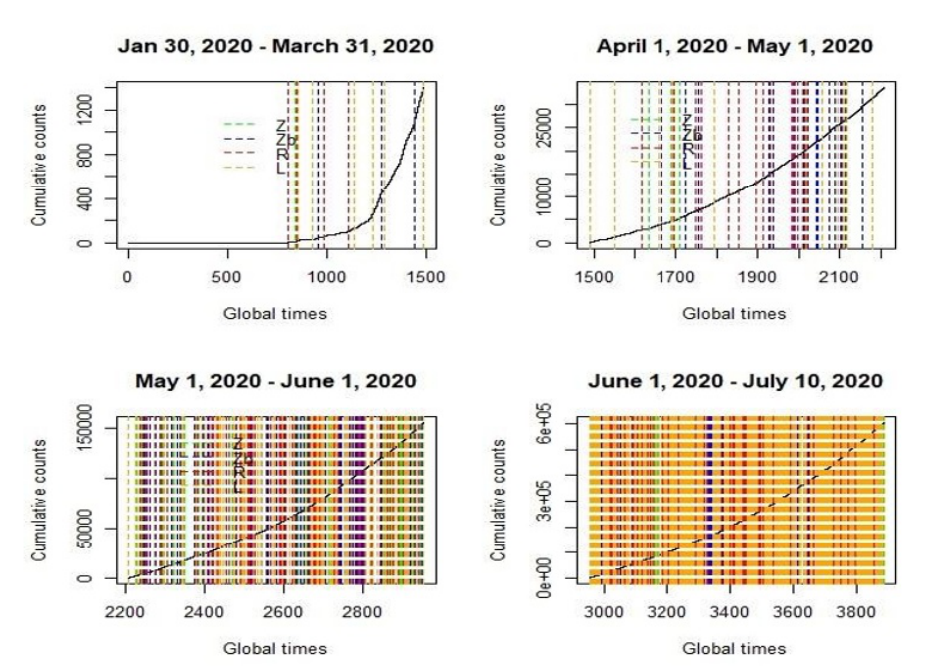
Fig. 9. Change point detection on the point processes storing COVID-19 infections in India over different